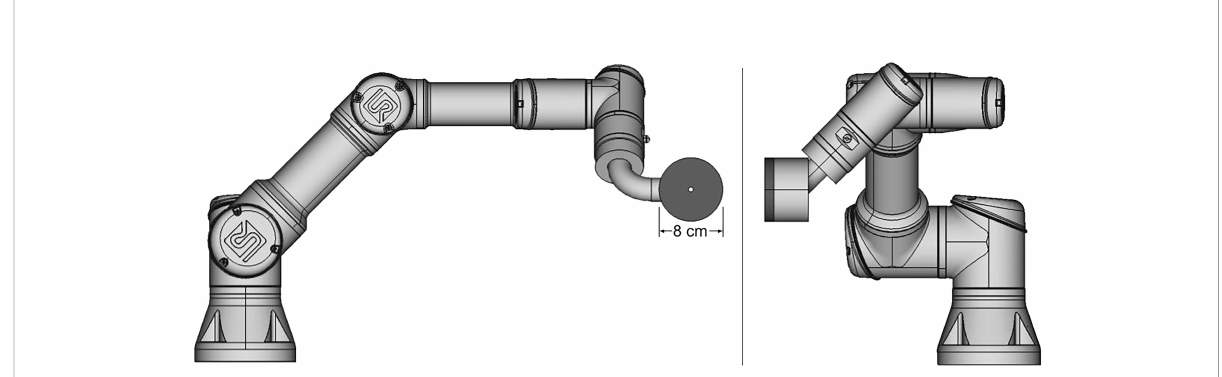
FIGURE 1 Diagram of a prototype spot scanning aperture (SSA) integrated with a collaborative robot, still under development. The aperture and range shifter assembly has a mass of about 2